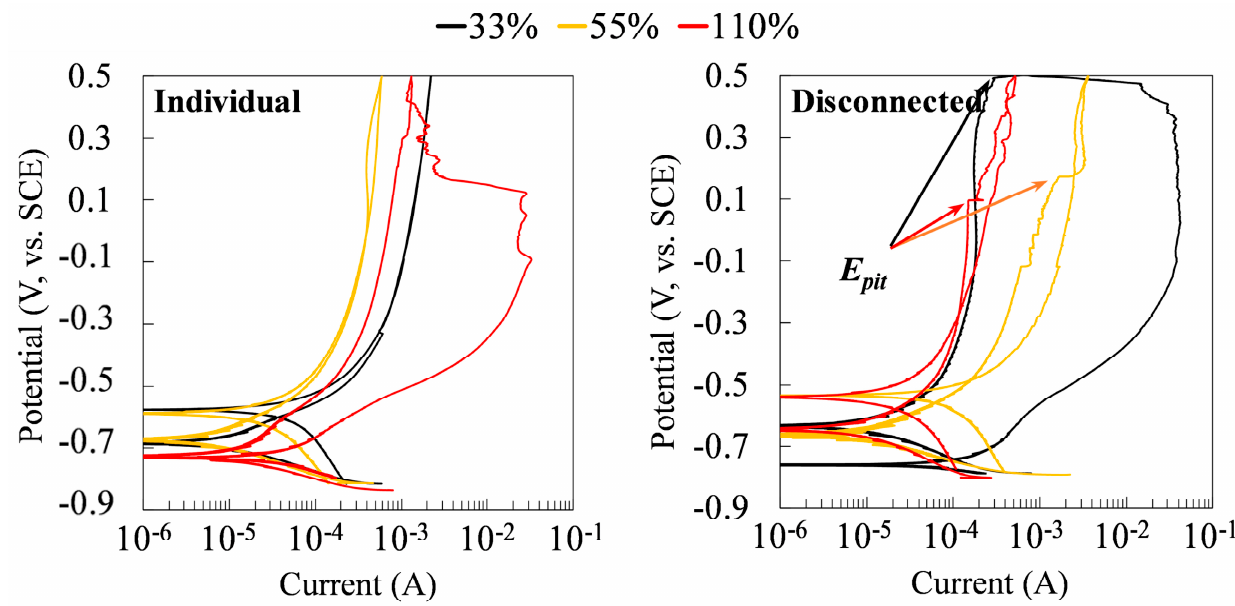
Figure 12. Cyclic polarization curves of the individual and disconnected stressed specimens in a galvanic couple at 75 days of exposure to the chloride-contaminated SCPS.